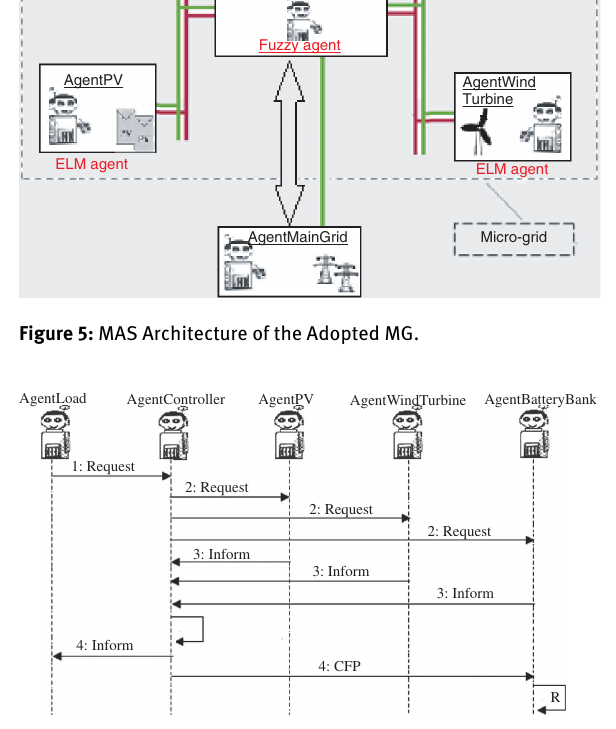
Figure 6: Interactions between Agents for Energy